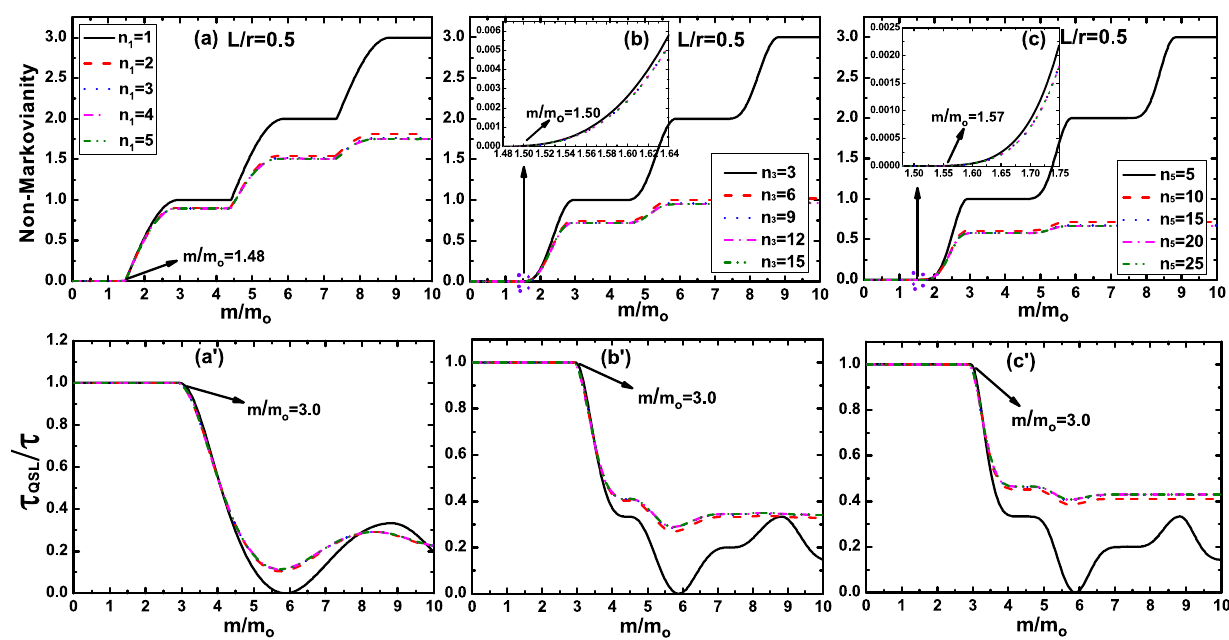
Fig. 3 For the two dimensional singular ray case ( x = 1, x = 3 and x = 5), and the actual evolution time τ = 0 . 4s, r =250 µ m, L = 0 . 5 r and m o =10 − 13 kg. a – c Non-Markovianity N (ϕ) of the dynamics process of the system particle m o as a function of m / m o with different number of the environment particles n x . a (cid:2) – c (cid:2) The QSLT